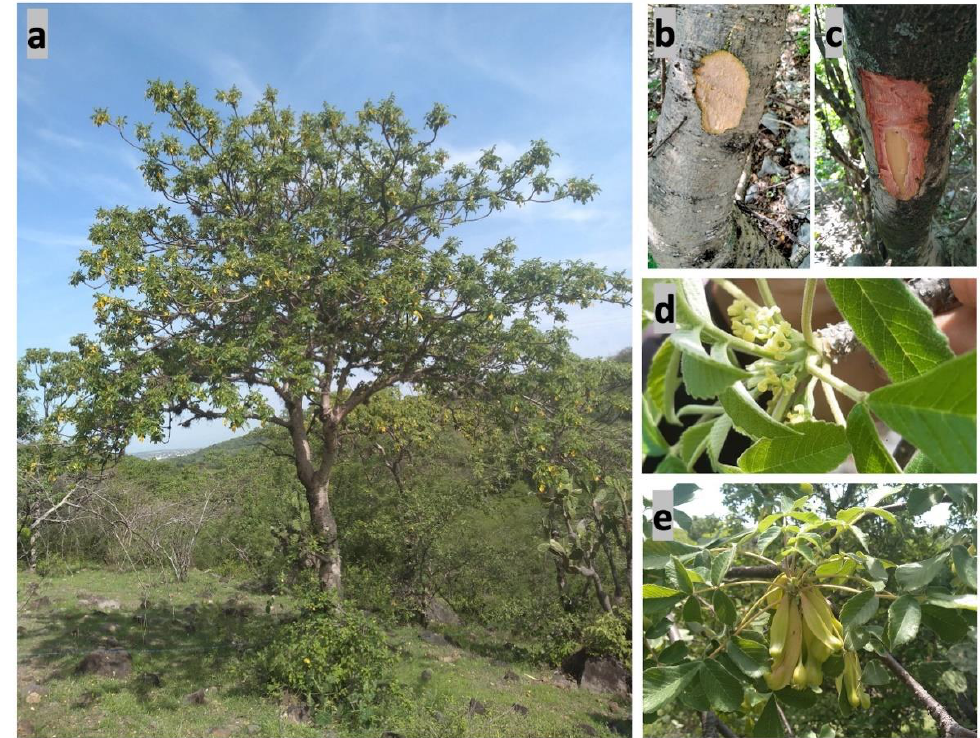
Figure 2. ( a ) A. adstringens tree in the rainy season, ( b ) whitish debarked stem commonly associated with female trees, ( c ) reddish debarked stem is associated with male trees, ( d ) female flowers, and ( e ) fruits. Pictures taken by M. Sotelo taken in Cuauchichinola (Mazatepec, Morelos, Mexico), June 2020. The leaves are arranged in a spiral, clustered at the end of the branches, odd-pinnate, and measure 6 to 13 cm. The petiole is composed of three to five opposite leaflets without a petiole, and the terminal leaflet is the longest. They are ovate or elliptic with a crenate